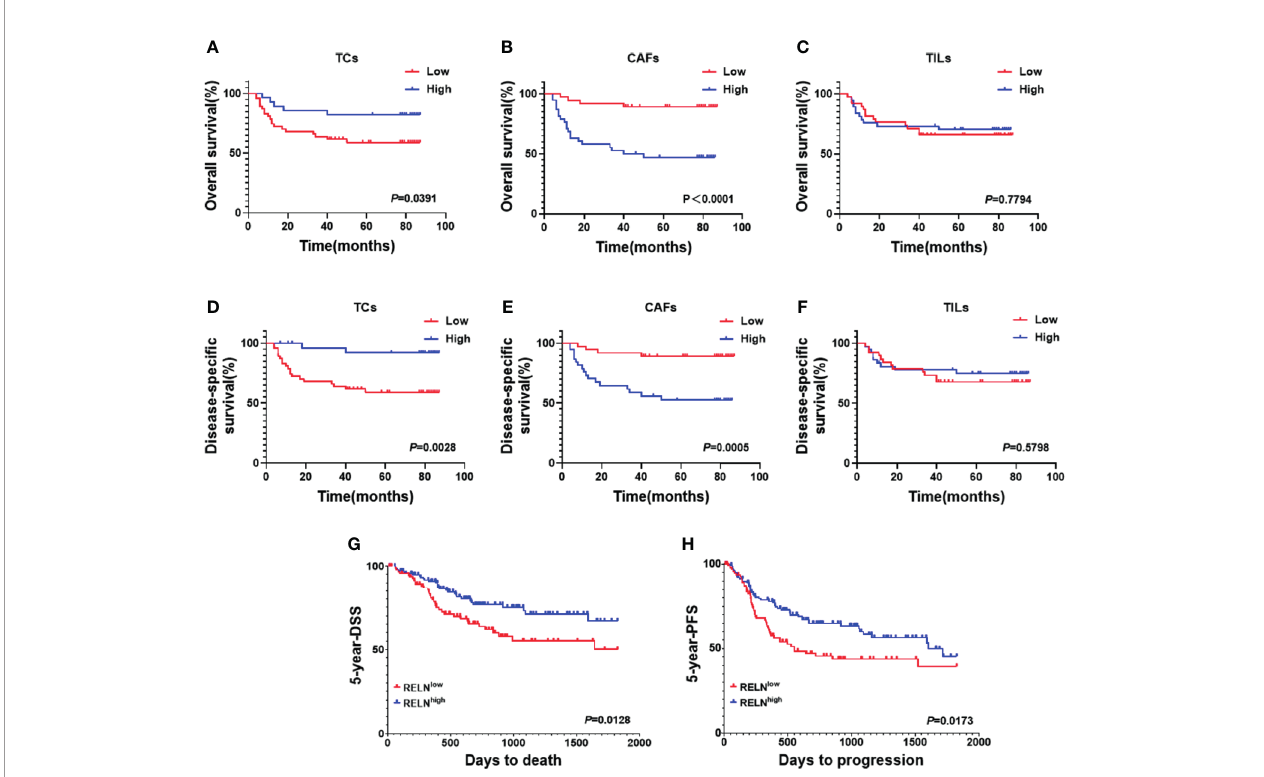
FIGURE 4 | Kaplan – Meier survival curves of OS (A – C) and DSS (D – F) for OSCC patients according to expression level of Reelin in TCs, CAFs, and TILs. Based on the TCGA database (TCGA.HNSC.sampleMap/HiSeqV2), Kaplan – Meier survival curves of DSS (G) and PFS (H) for OSCC patients according to expression level of